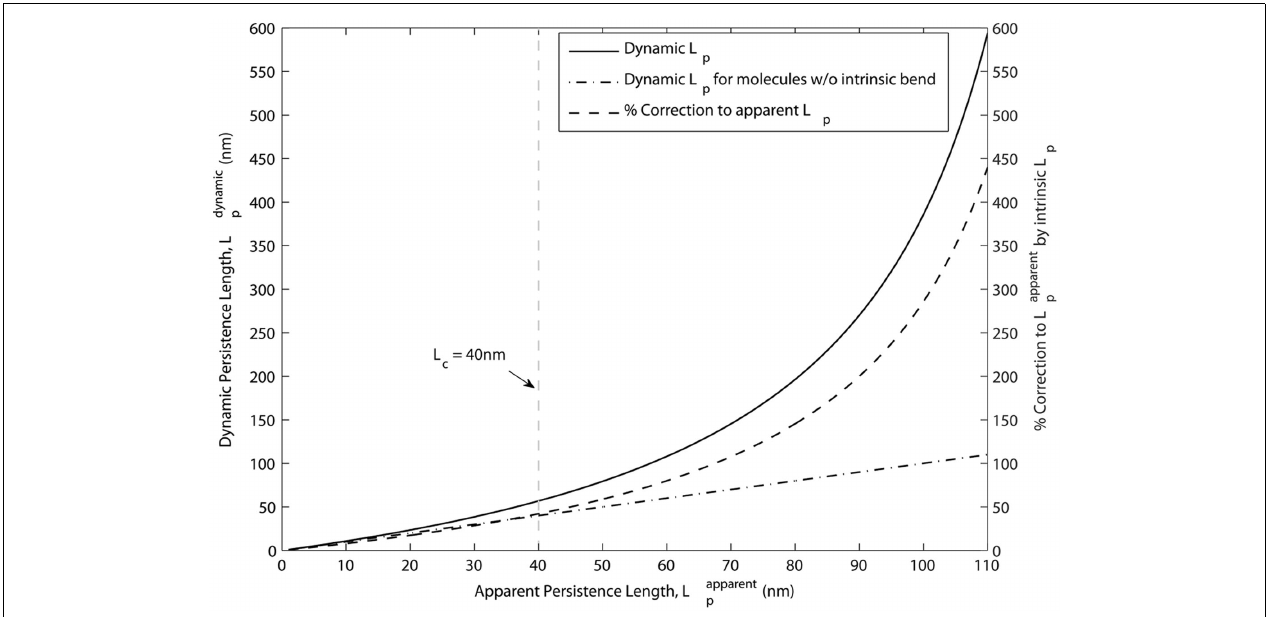
FIGURE 4 | Correction due to intrinsic curvature of tropomyosin is less significant when apparent L p approaches the contour length. According to Eq. 1, the percentage correction to apparent L p due to intrinsic L p (dashed line, right axis) is non-linear and is much smaller at values of apparent L p ≤ L c than at longer values. Dynamic L p (solid line, left axis), measurement of the